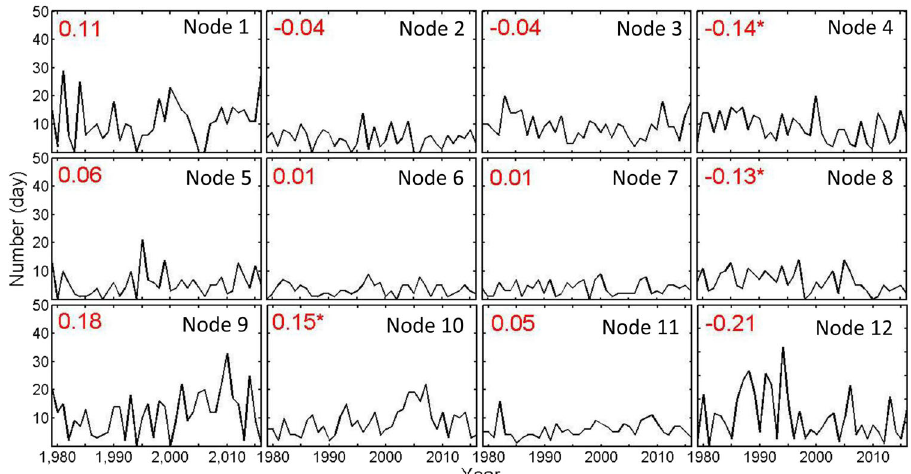
Fig. 3 Time series of occurrence number and its trend (red numbers, in day yr − 1 ) for each SOM pattern in Fig. 2. Red asterisks indicate the trends signi fi cant at 95% con fi dence level.